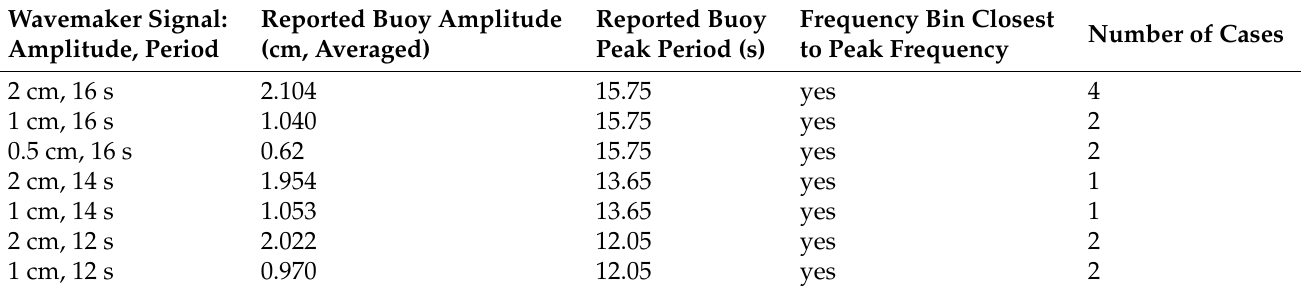
Table 4. A summary of wavemaker signal experiment results. The experiments included 1 and 2 cm amplitude waves for 12, 14, and 16 s periods, as well as an “extreme” test corresponding to an amplitude of 0.5 cm at a 16 s period. The mean values are reported for the multiple tests conducted. The instrument is able to accurately measure waves down to 1 cm at a 16 s period, with a corresponding typical accuracy of under 0.1 cm. For waves of amplitude 0.5 cm and period 16 s, the peak period is still correctly identified, but noise in the measurements starts to play a role, with a deviation of around 25% in the wave amplitude value